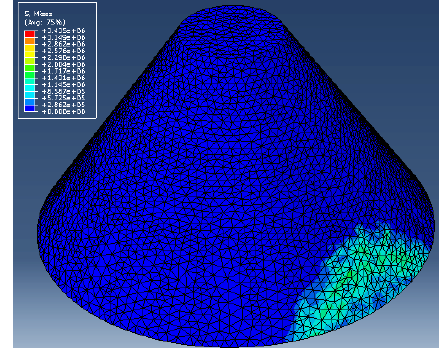
Fig. 6. Von misses composite stress contour in the frustum building in a moment after explosion strikes building on the ground